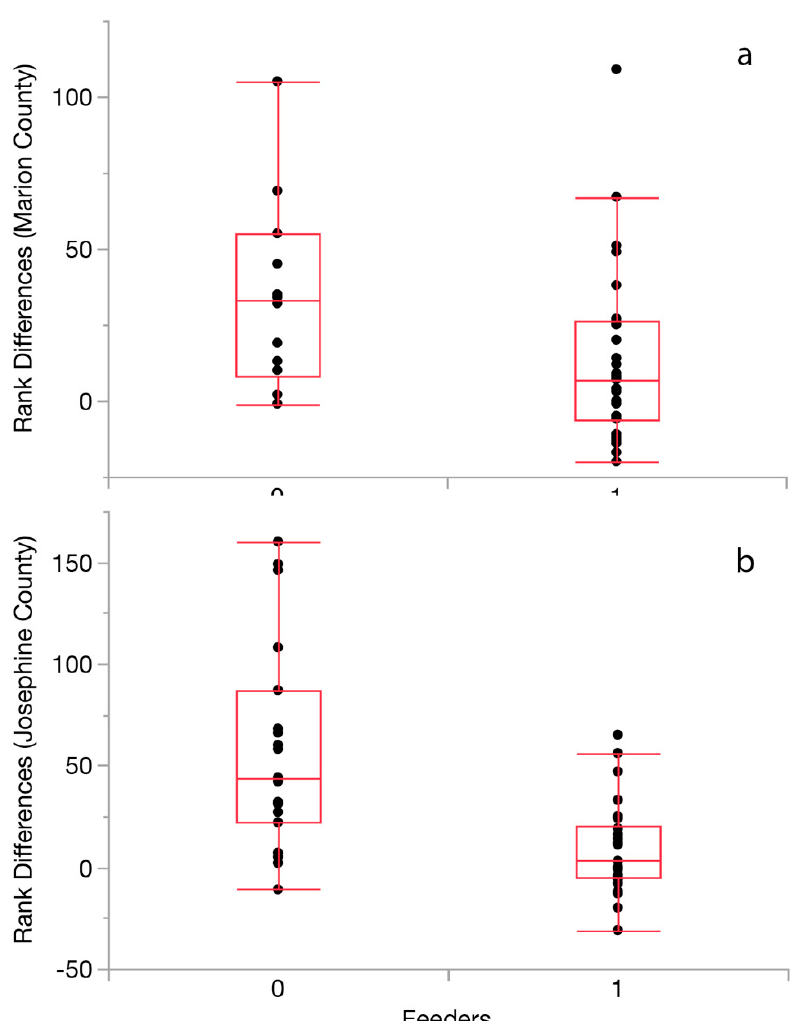
Figure 3. Rank differences between species using feeders (1) and species that do not use feeders (0) as related to their indices of abundance in Marion ( a ) and Josephine ( b ) Counties.